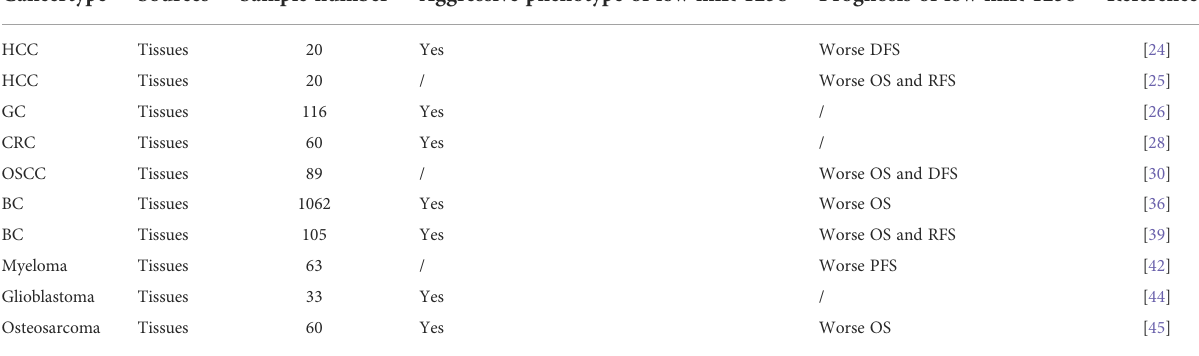
TABLE 2 Clinical implication of miR-1258 in human